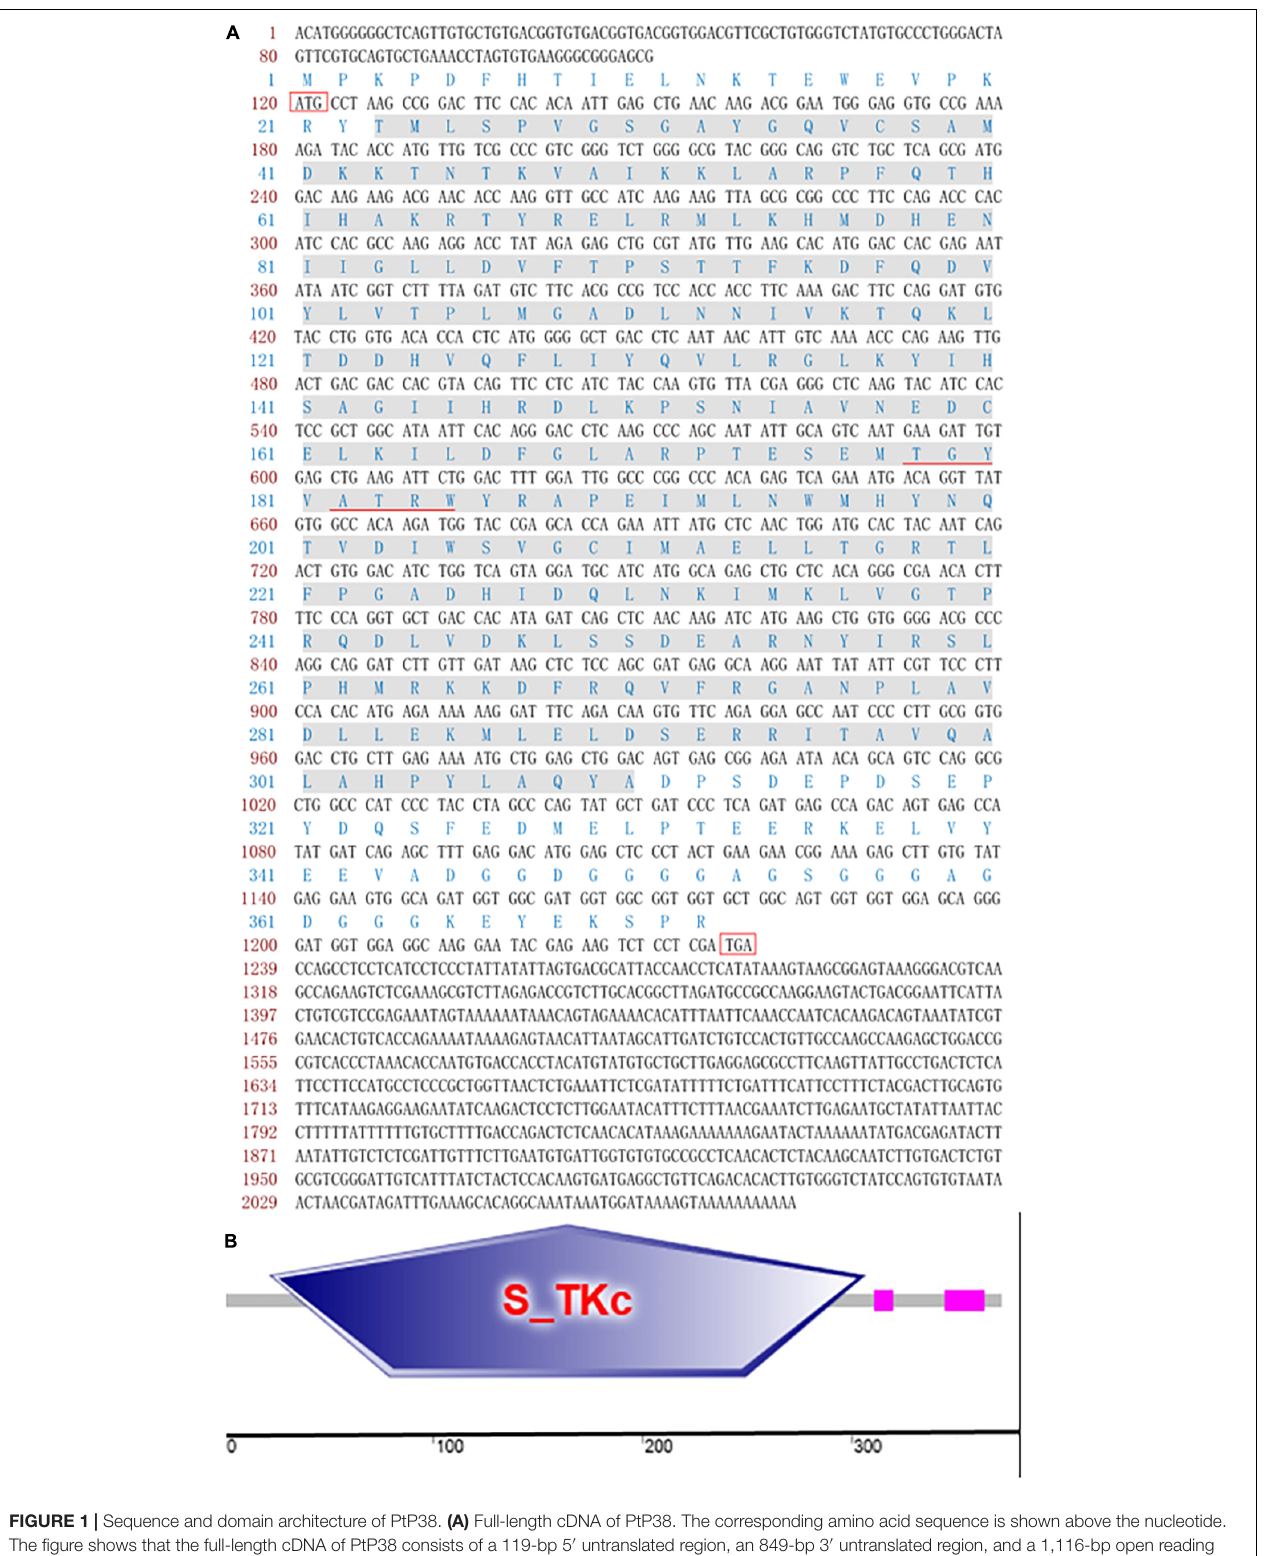
Frontiers in Marine Science |